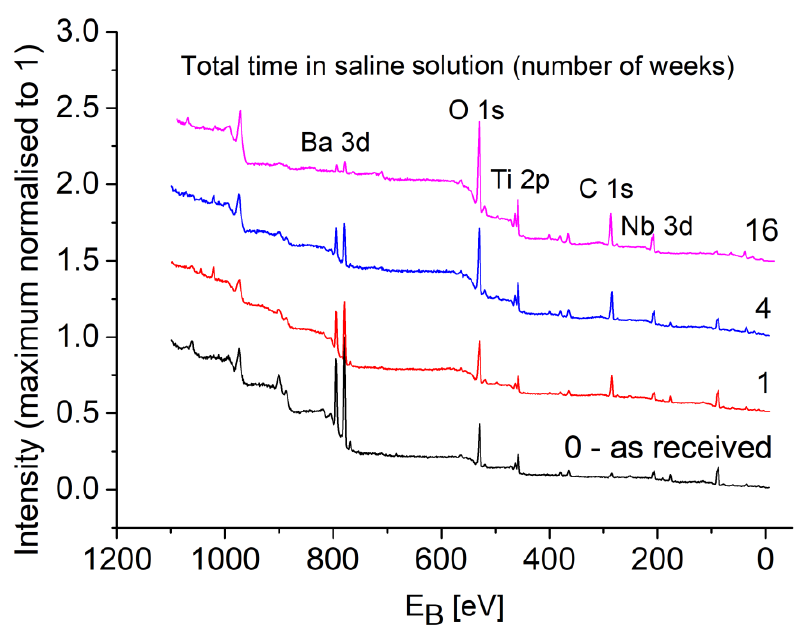
Figure 6. Wide photoelectron spectra of a BaTiO 3 film deposited on Ti39Nb. The sample was immersed in the physiological saline solution, and the dependence of Ba release from the sample on the total time of immersion is visible in the spectra. Particular total times of immersion (i.e., 1, 4, and 16 weeks) are specified near every spectrum. The analysis was performed on a circle of 5 mm in diameter on one sample per experimental group.